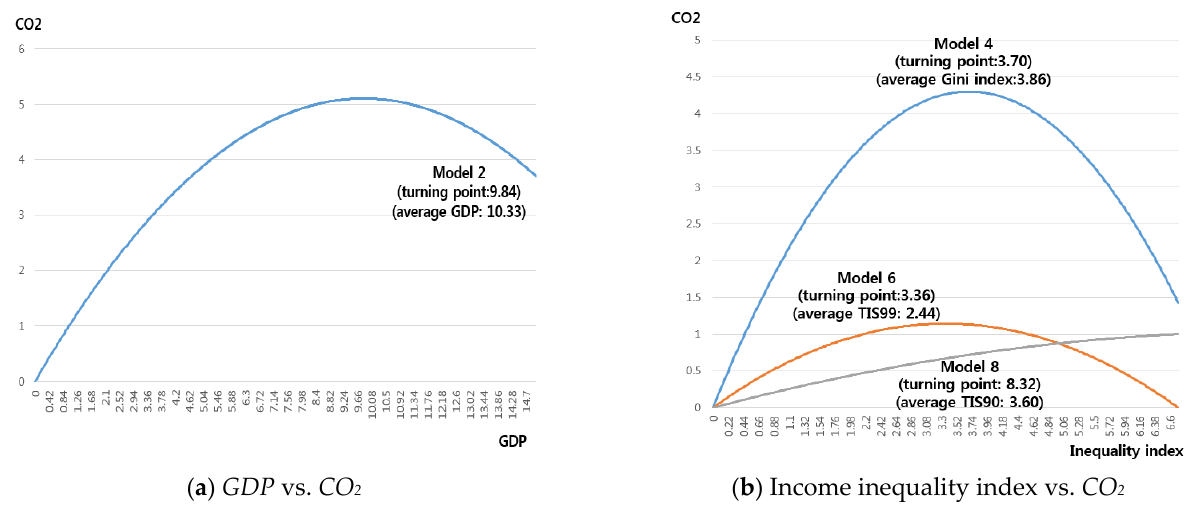
Figure 4. The relationship of income inequality and GDP for CO 2 emissions. Source: Author’s own elaboration based on World Bank (2022) WDI [29] and WID (2022) [30].